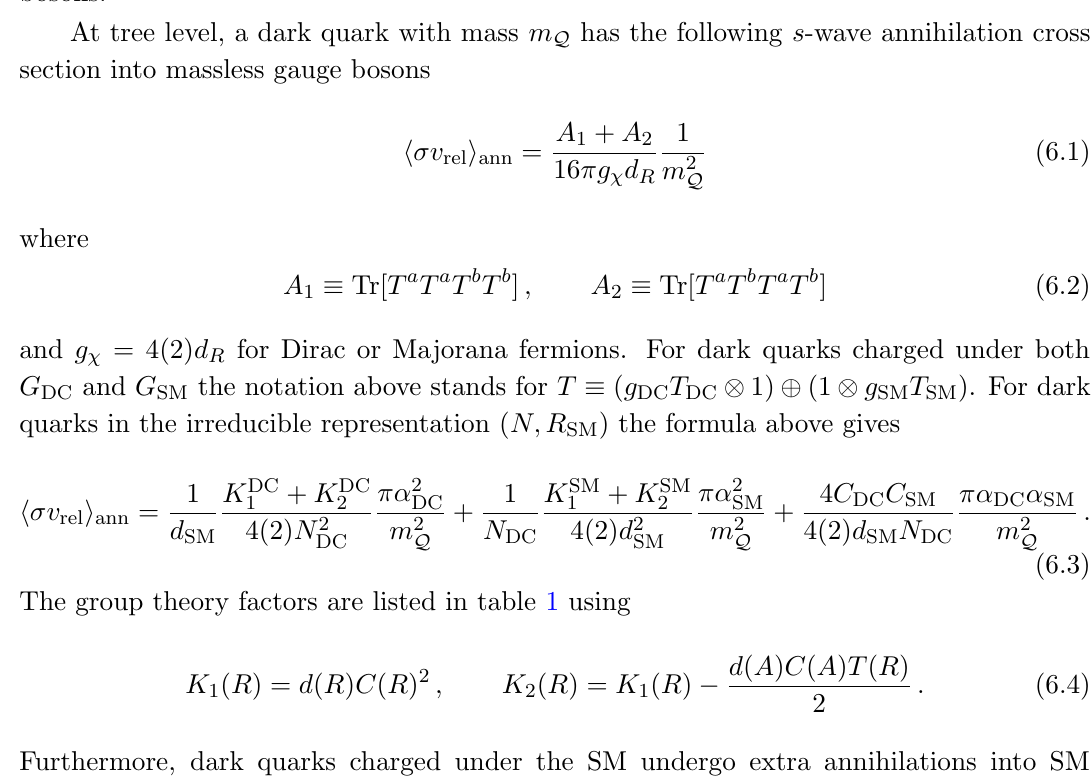
Table 3 . Group-theory factors for formation of a bound state in the representation R initial state in the representation R i and